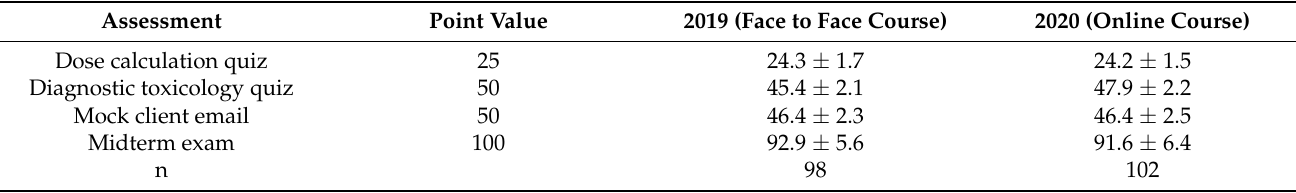
Table 1. Student performance on course assessments. All assessments used were identical in both 2019 and 2020 courses. Bold text indicates a statistically significant difference ( p < 0.05, unpaired two-tailed t